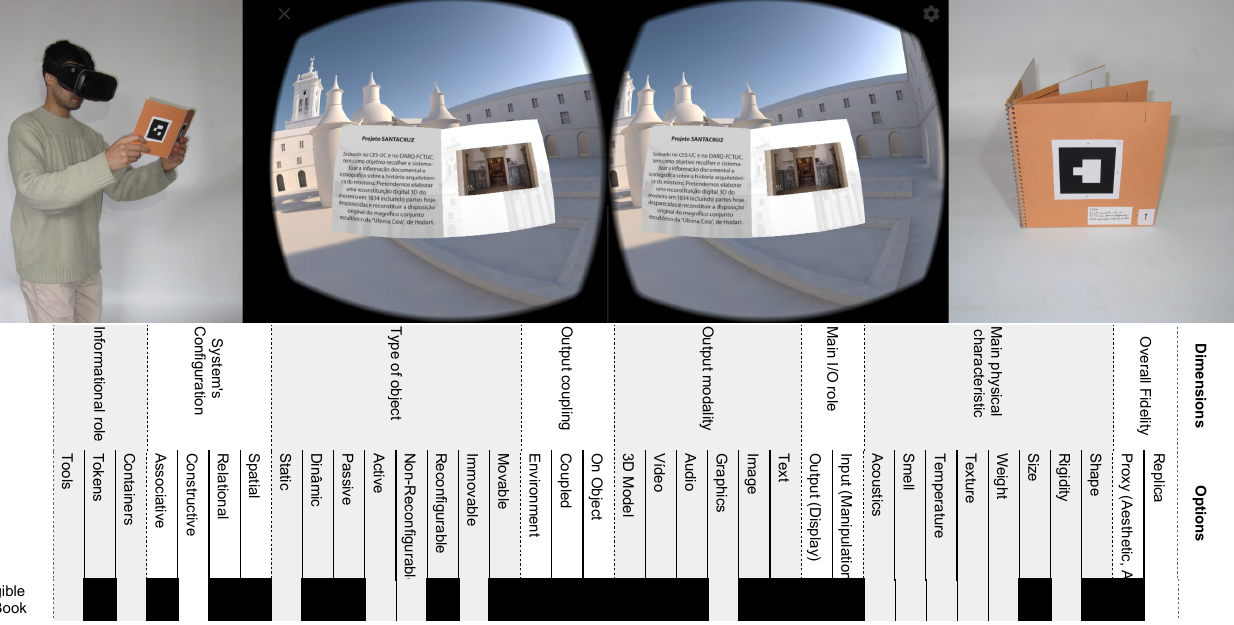
Figure 3. Overview of the Tangible VR Book ( top ); Instantiation of the Marker-based TUI Design Space in the Tangible VR Book ( bottom